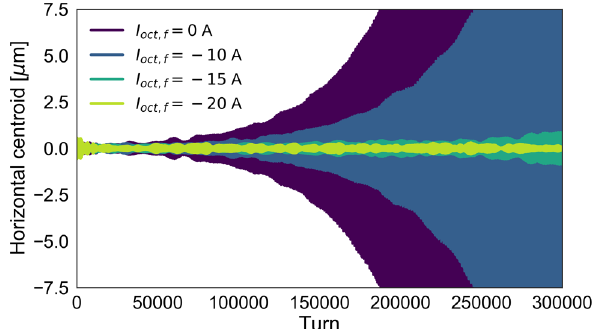
FIG. 9. P y HEADTAIL results of the bunch centroid motion over 3 × 10 5 turns in the LHC for different values of the currents in the Landau octupole